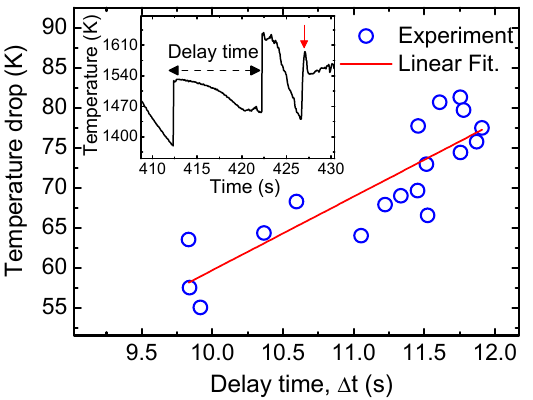
Figure 3. Relation between temperature drop (marked by a red arrow in inset) on heating curve and delay time. The degree of the temperature drop increases with increasing delay time.